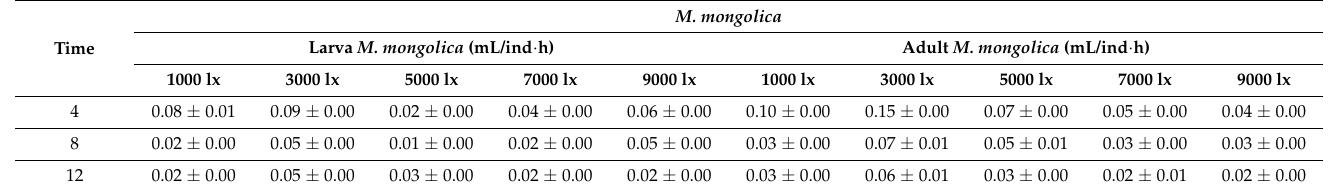
Table 4. Water filtration rates of M. mongolica at two age stages under different light intensities (data are listed as mean ± standard deviation).